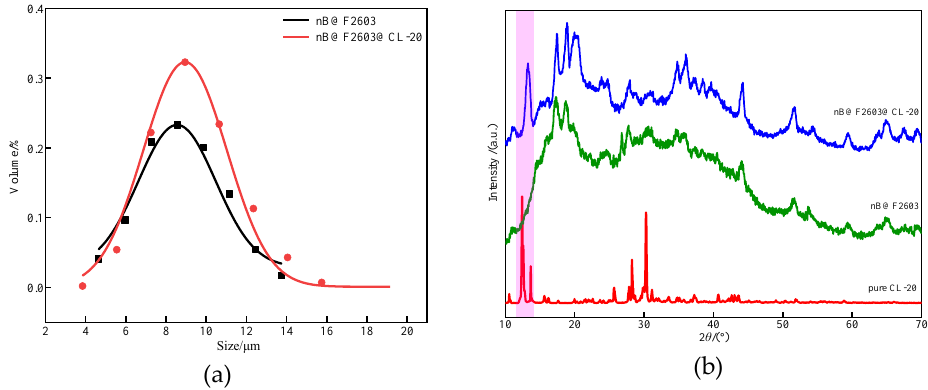
Figure 5. ( a ) Particle size distribution and ( b ) XRD patterns of nB@F2603@CL-20